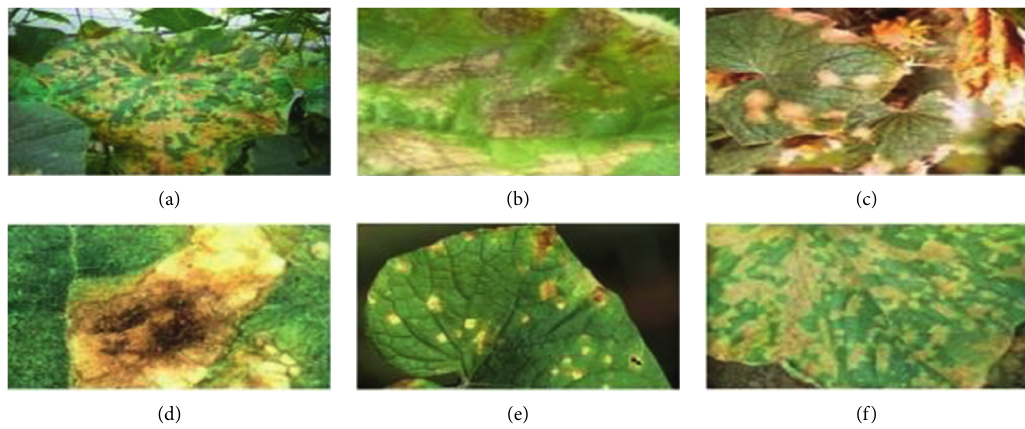
Figure 3: Cucumber diseased leaf dataset. (a) Angular leaf spot. (b) Anthracnose. (c) Blight. (d) Corynespora . (e) Downy mildew. (f) Powdery